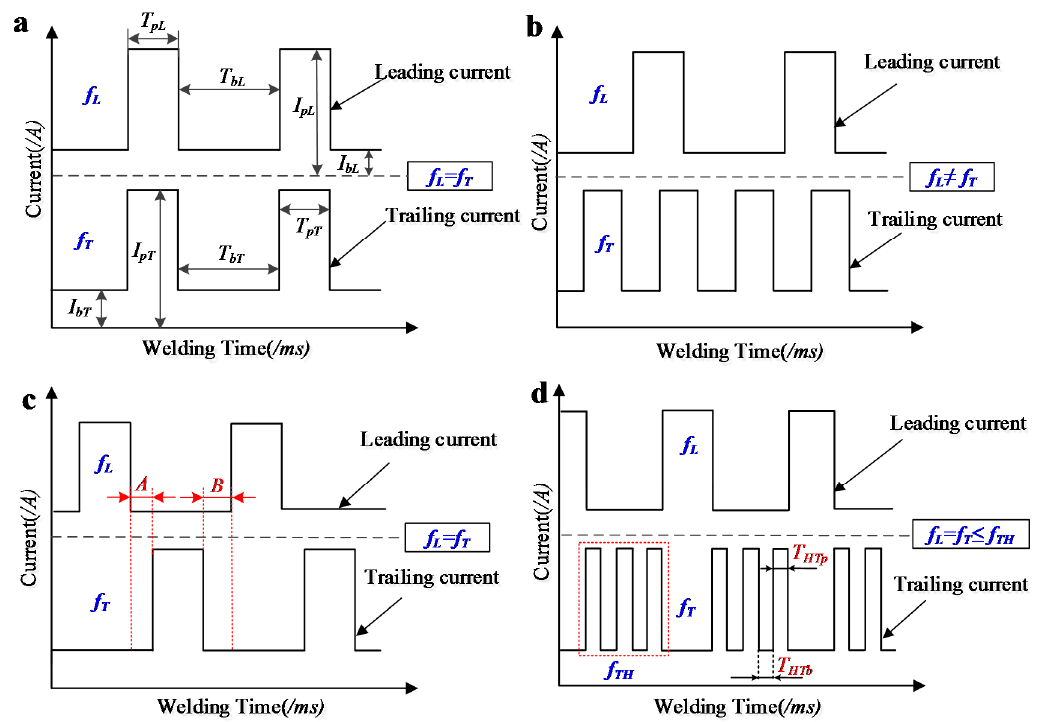
Figure 3. ( a ) Current waveforms (same frequency and inverse phase pulse); ( b ) current waveforms (same frequency and same phase pulse); ( c ) current waveforms (different frequency and different phase pulse); and ( d ) multi-frequency double-wire waveforms.